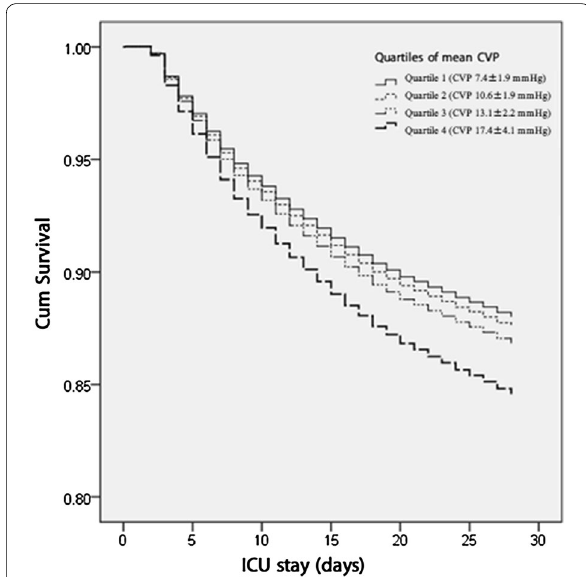
Fig. 2 Survival curve of 28‑day mortality by the quartiles of mean CVP level in the patients in the critical care settings. CVP central venous pressure